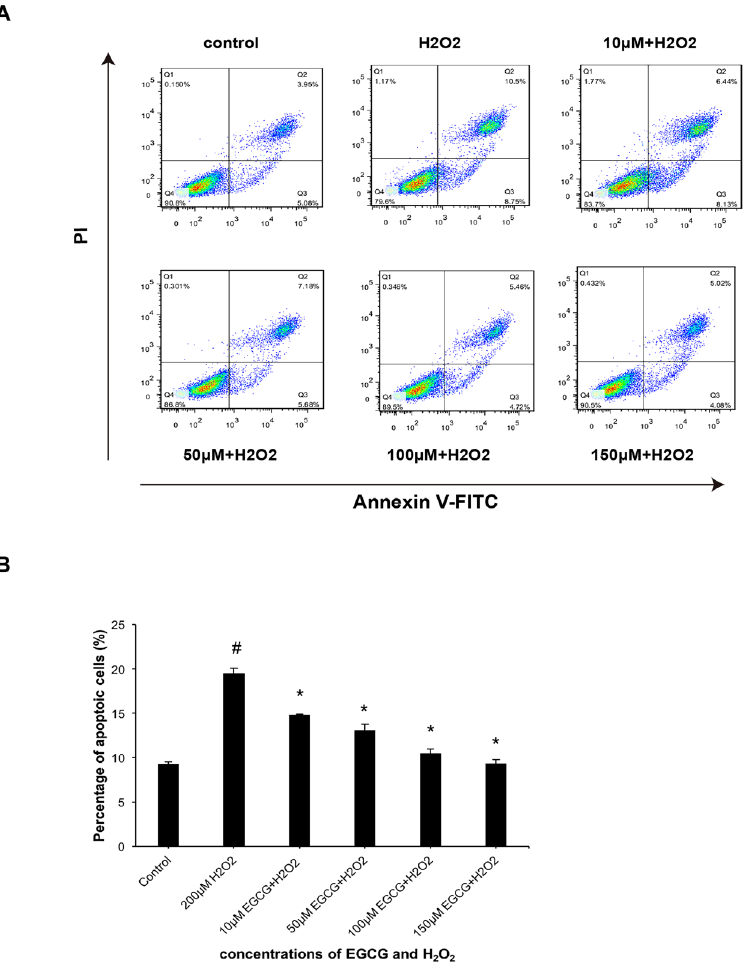
Figure 2. EGCG reduced H 2 O 2 -induced apoptosis in VSMCs. ( A ) VSMCs were pretreated with 10, 50, 100, or150 μ M EGCG for 2 h, followed by treatment with 200 μ M H 2 O 2 for 30 min. Annexin V-FITC/PI staining and flow cytometry was used to assess the rate of apoptotic cells, which was defined as the sum of early and late apoptosis events. Flowjo software was used to analyze flow cytometry results. ( B ) Statistical data were represented based on experiments performed in triplicate. Results were expressed as Mean ± S.D (n = 5). * P < 0.05 vs. H 2 O 2 treatment group, # p < 0.05 vs. control